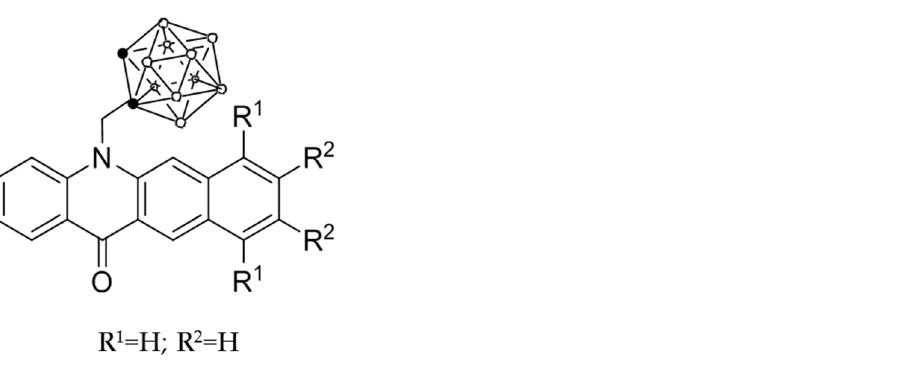
Figure 13. Schematic representation of 7-carboranylmethylbenzo[b]acridin-12(7H)-one, hereafter CMBA.